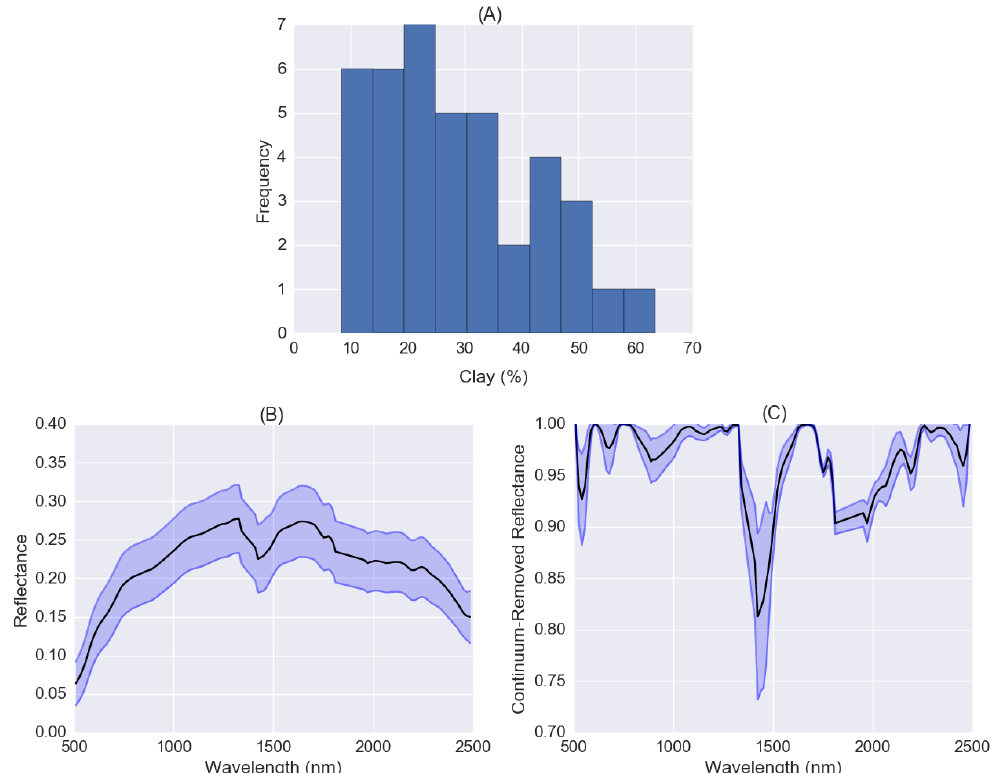
Figure 7. Absorption feature near 2200 nm for the mean spectrum of mineral soils ( A ), and scatter plots between soil clay contents and the corresponding short-wave infrared fine particle index (SWIR FI) values for mineral ( B ), and organic soils ( C ).